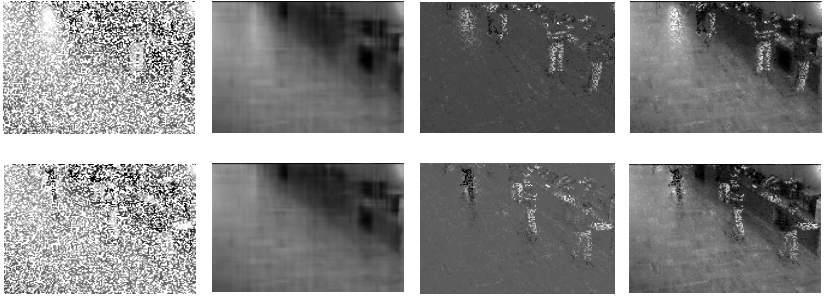
Figure 7. Background modeling from lobby video. ( a ) draws the images with missing entries, ( b ) plots the recovered background, i.e. the low-rank images, ( c ) shows the recovered foreground, i.e., the sparse noised images, and ( d ) displays the recovered images.